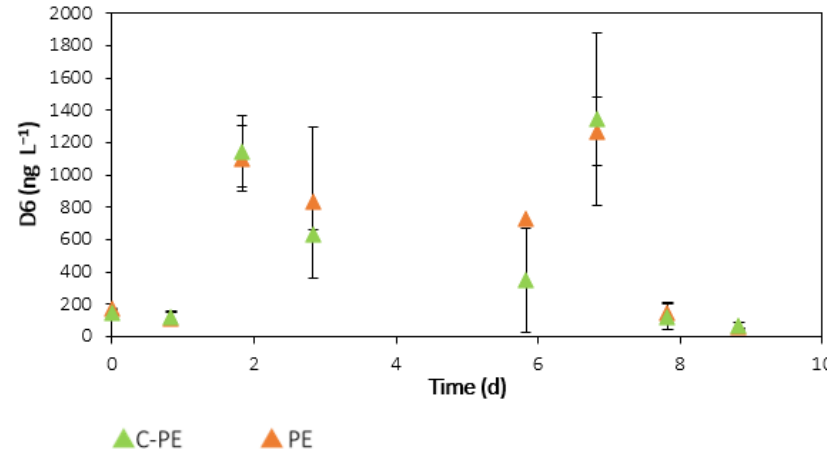
Figure A1. Time-course evolution of D3 ( a ), D4 ( b ) and D6 ( c ) concentrations for the C-PE and PE experiments.